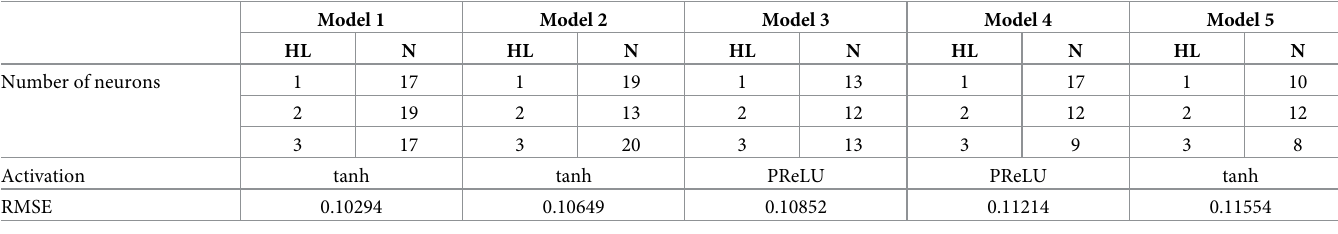
Table 10. Hyperparameter search results summary (Run 3). Top 5 Models out of 250 candidate models from Run 3.